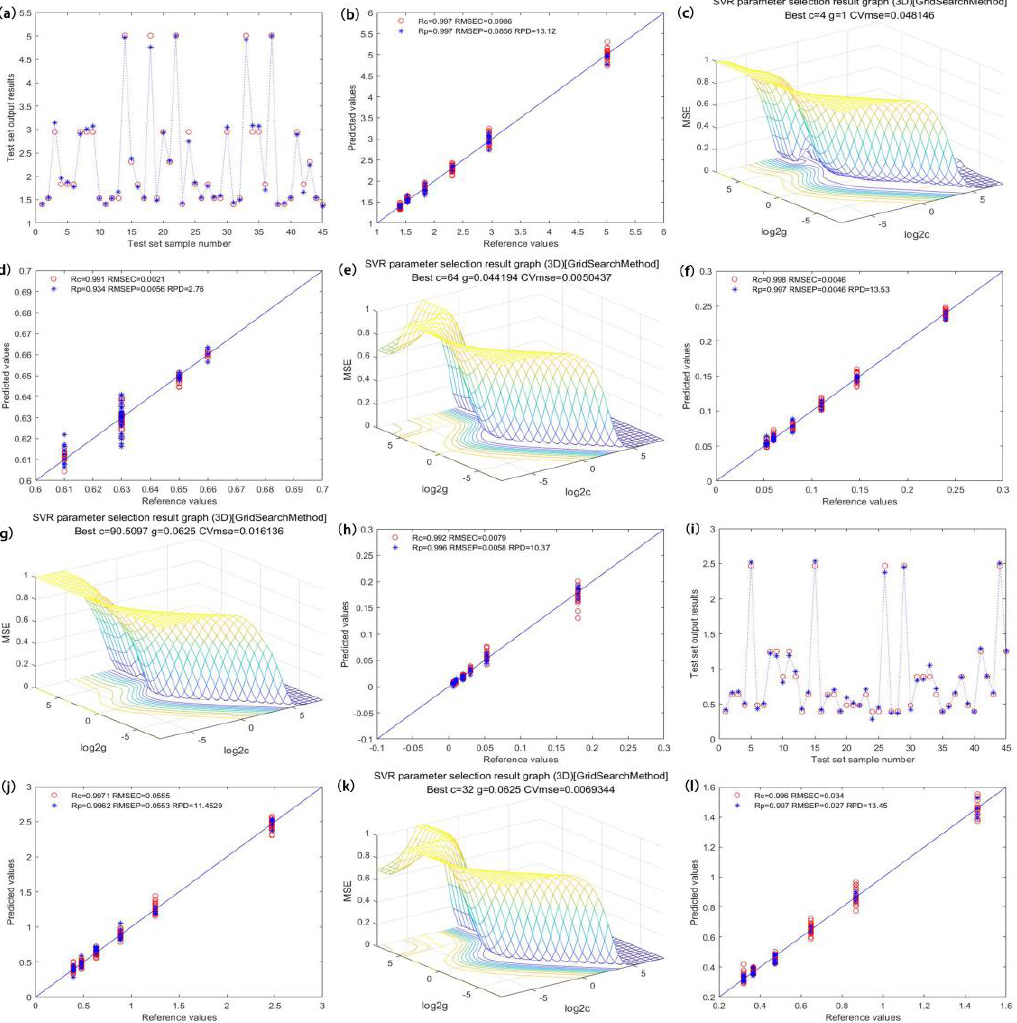
Figure 5. Optimal model optimization results and prediction effects of the content of catechin components. (( a , i ) are the prediction effects of the total catechin model and the EGCG model, respectively; ( c , e , g , k ) are the internal parameter optimization diagrams of EGC, C, EC, and ECG models, respectively; ( b , d , f , h , j , l ) are the predicted scatter plots of the total catechins, EGC, C, EC and ECG models, respectively).